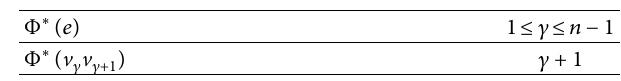
Table 22: Edge labeling of Φ ∗ ( e ) .